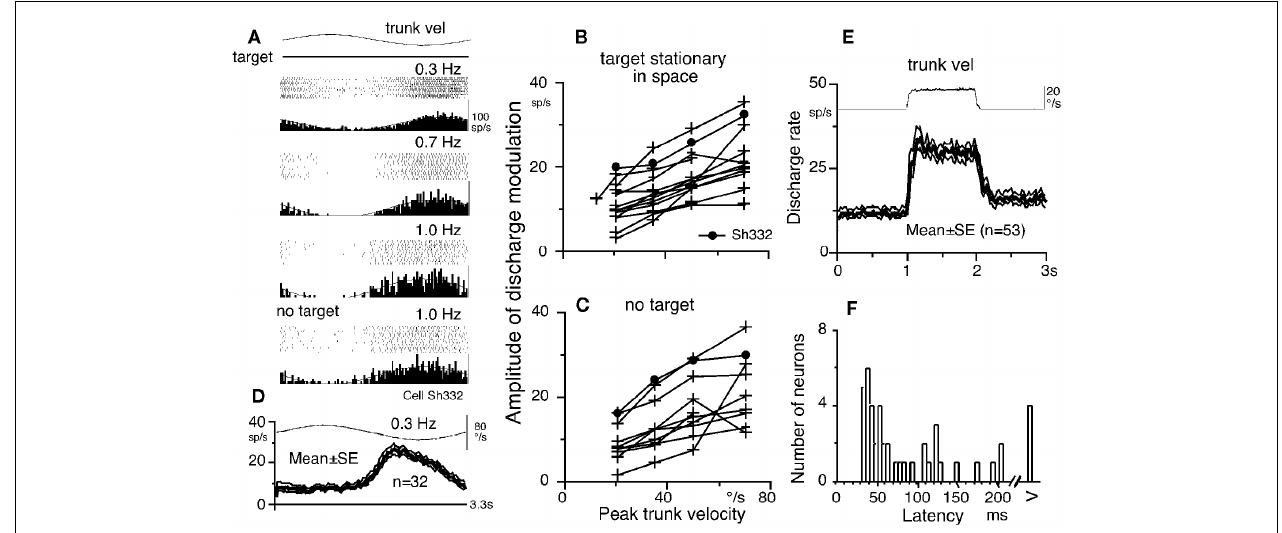
In (C) , trunk-on-head rotation was applied in complete darkness without a target. (D) Mean ± SE discharge of population of 32 pursuit neurons during passive trunk-on-head rotation while the monkeys fixated a stationary spot in space. (E) Mean ± SE discharge of population of 53 pursuit neurons to velocity step rotation. (F) Latency histogram of pursuit neurons to velocity step trunk-on-head rotation. Reproduced from Fukushima et al. (2010) with